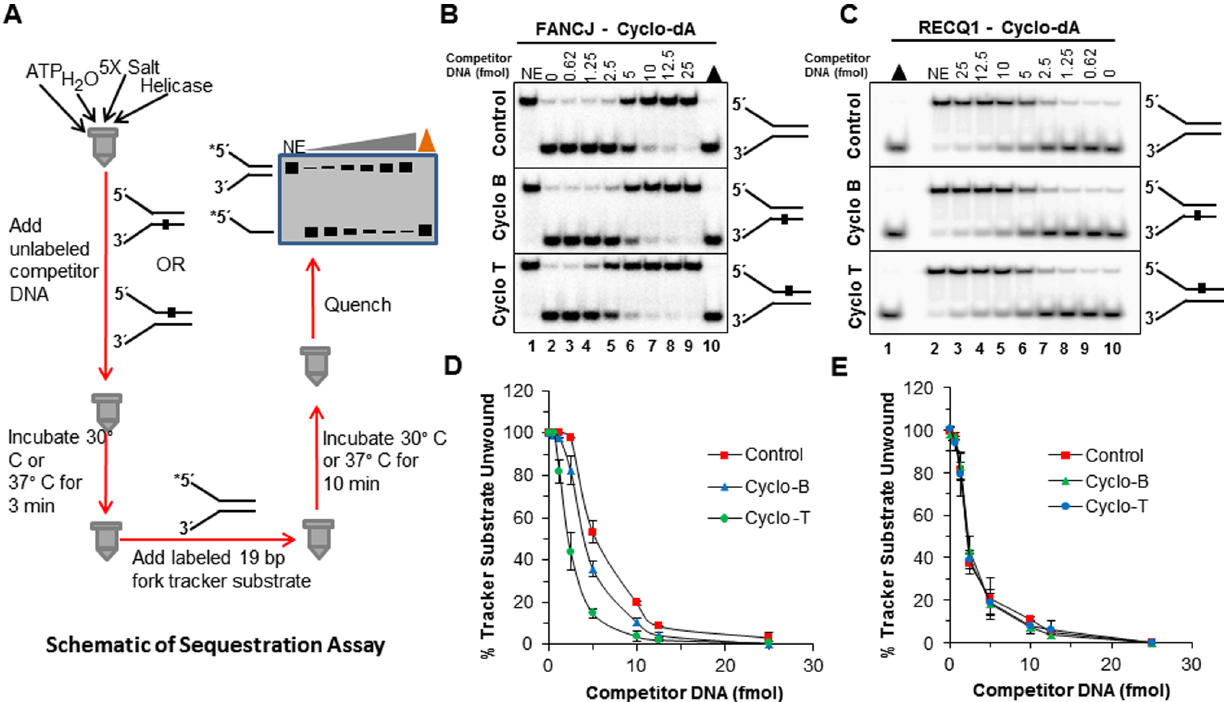
Figure 7. Sequestration of FANCJ, but not RECQ1, by cyclo dA. A, Schematic of sequestration assay. Sequestration assays were performed with 9.6 nM FANCJ or 8.8 nM RECQ1 and the indicated concentrations of the competitor DNA forked duplex at 30 u C (FANCJ) or 37 u C (RECQ1) under sequestration assay conditions described in the Materials and Methods. B and C, FANCJ ( B ) or RECQ1 ( C ) unwinding of undamaged 19 bp tracker DNA substrate after incubation with unlabeled forked duplex DNA molecules that contained cyclo dA in the top, bottom, or neither strand. D and E, Quantification of FANCJ and RECQ1 helicase activity from representative sequestration experiments shown in panels B and C , respectively.